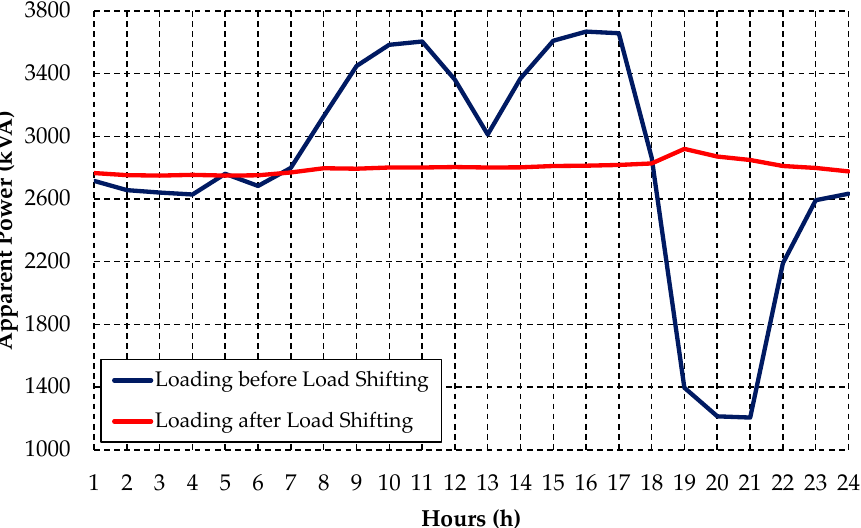
Figure 21. Rural Feeder B loading before and after load shifting for irrigator customers. Source: The authors.